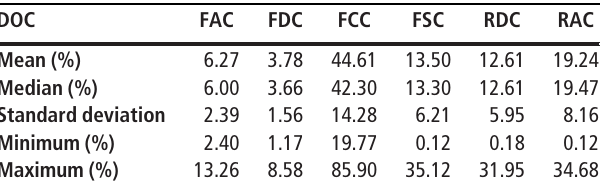
Table 7 Statistical analysis of different longitudinal